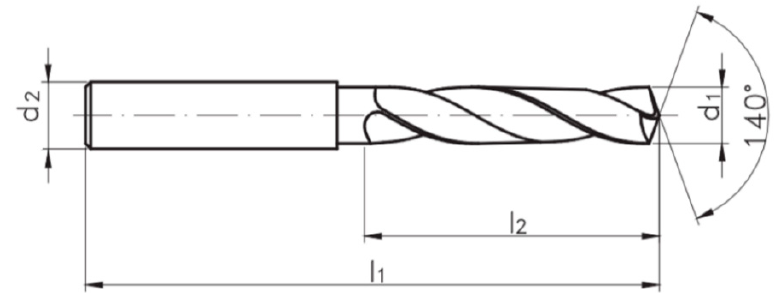
Figure 4. FANAR W9-604013-1000/WK DIN-6537 3xD 10.00 VHM solid carbide twist drill ( d 1 = 10 mm, d 2 = 10 mm, l 1 = 89 mm, l 2 = 47 mm).